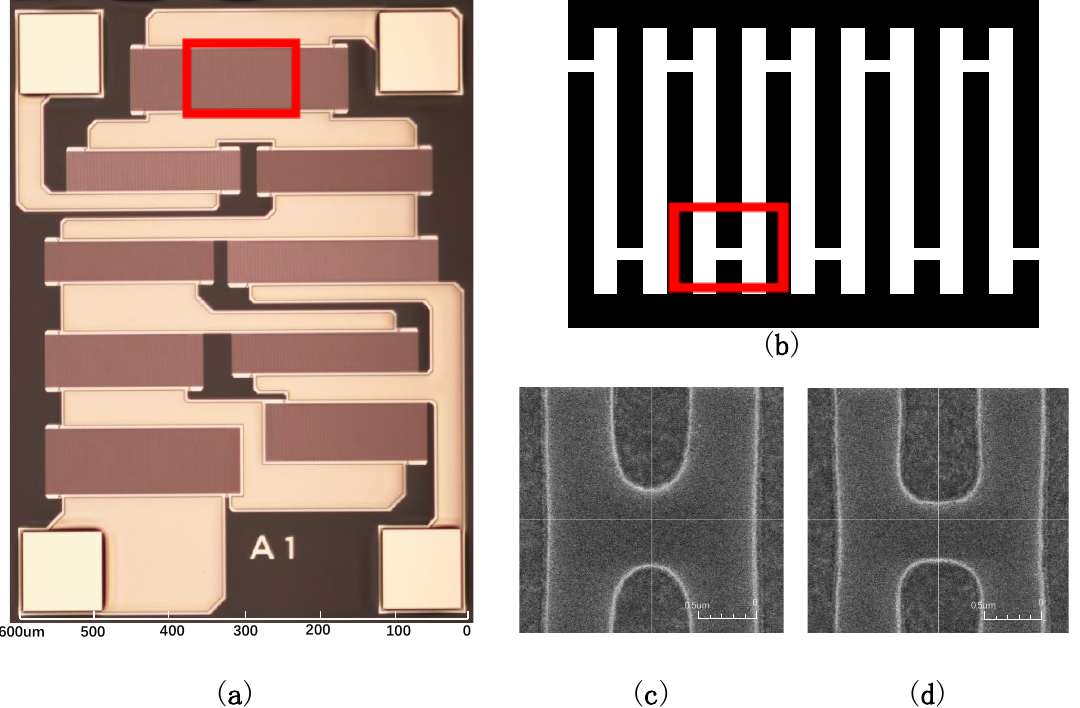
Figure 11. The physical map of the filter and local SEM comparison before and after OPC at both ends of the electrode gap: ( a ) the physical map of the filter; ( b ) the local schematic of the resonator in ( a ); ( c ) before OPC; ( d ) after